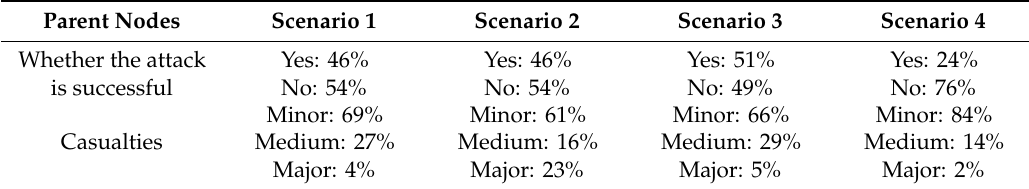
Table 4. Results of four di ff erent